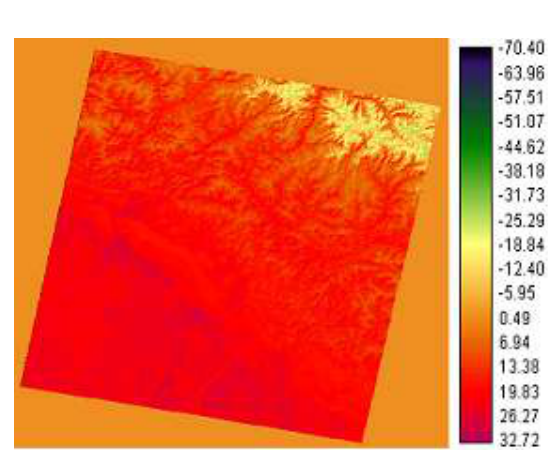
Fig. 4 Pattern of Estimated Temperature 1990 Fig.5 Pattern of Estimated Temperature